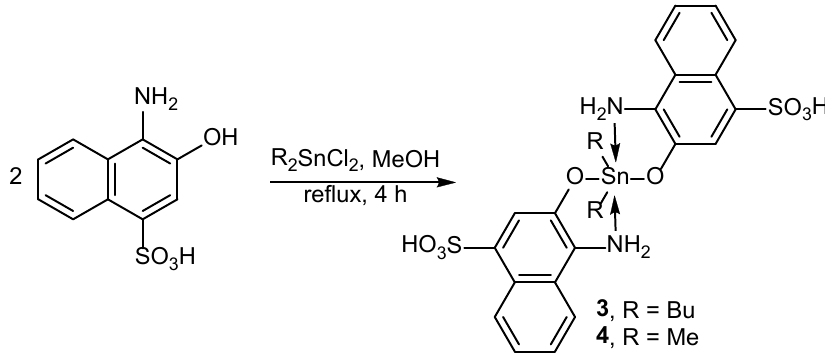
Table 1. Physical properties of tin-naphthalene sulfonic acid complexes 1 – 4 .